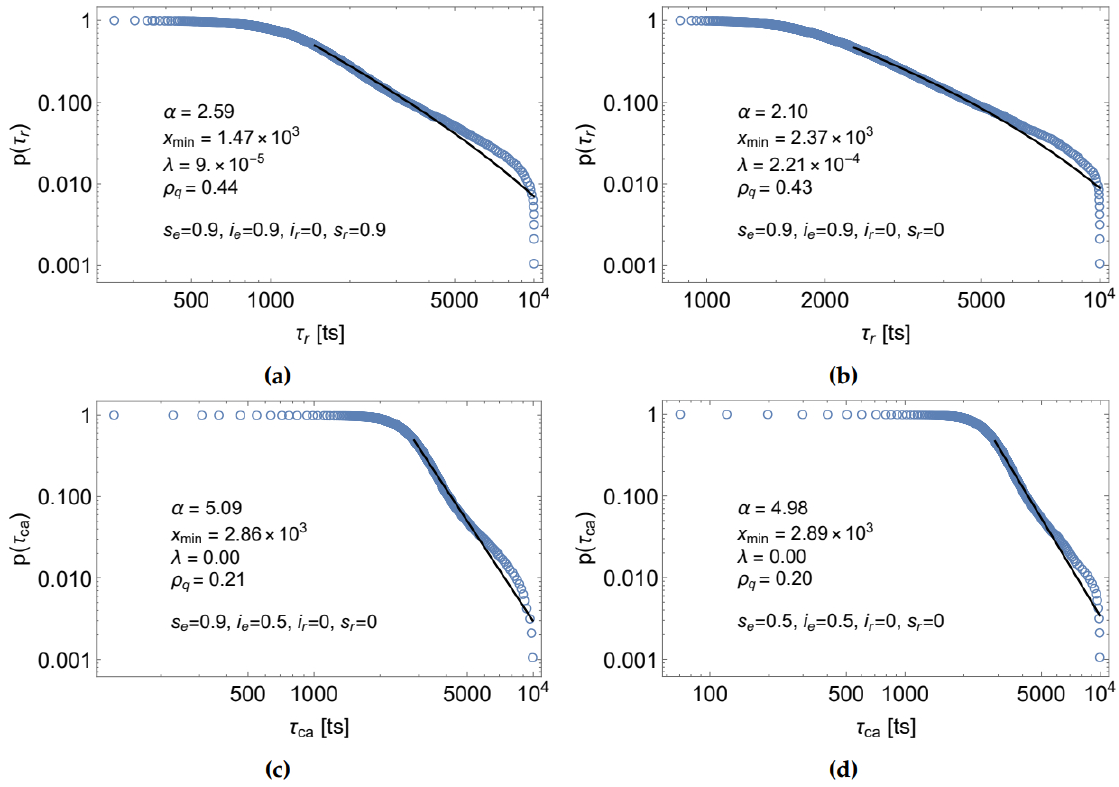
Figure 5. Log-log scale plots of the resting time τ r (top) and the collision avoidance time τ ca (bottom) distributions in DCM. The black lines represent the corresponding truncated power law fits. The insets show the fit parameters as well as the scenario configurations. The plots ( a , b ) differ by the scenario configurations shown in the insets; similarly for ( c , d ). These scenarios belong to a subset of the best swarm performance with respect to ω ca . Please note that λ = 0 for the fits of τ ca , indicating better support for the power law fit than for truncated power